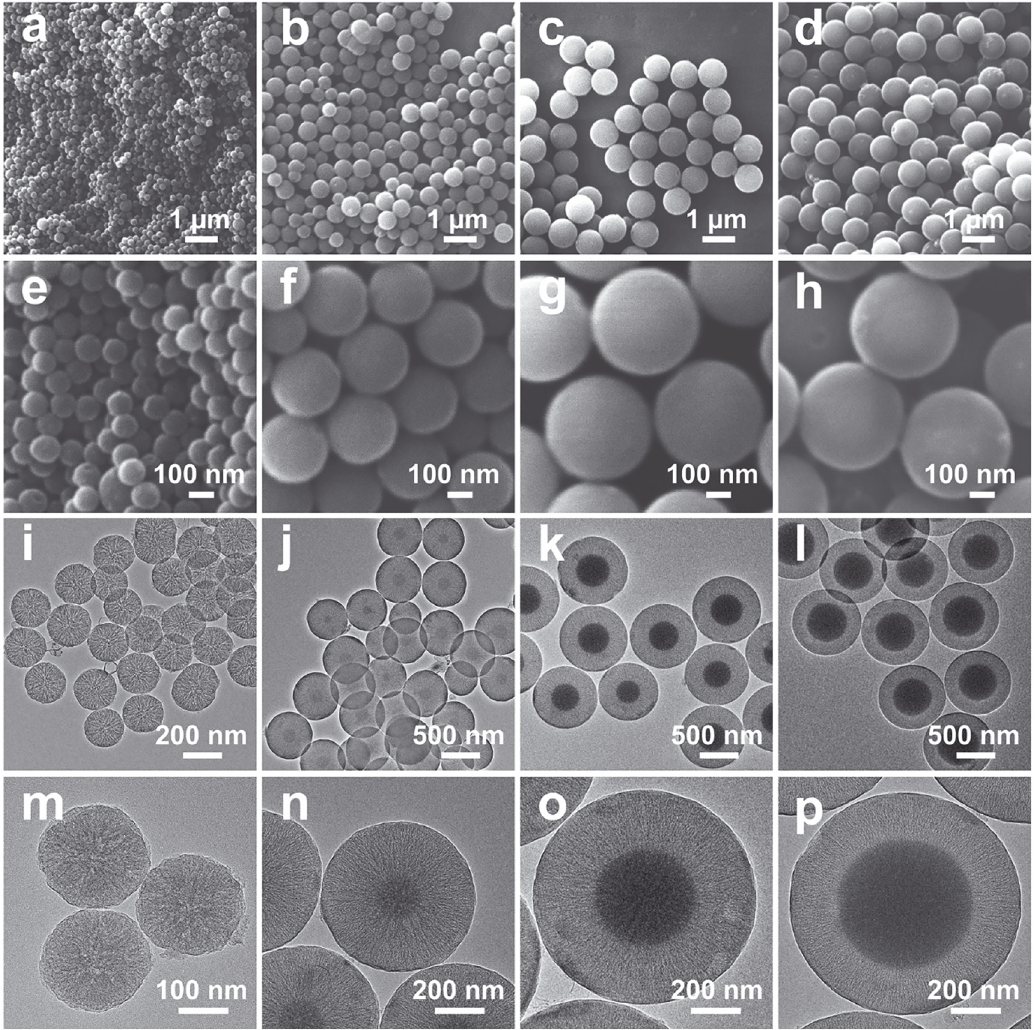
Figure 1: SEM images (a–h) and TEM images (i–p) of MCS-1 (a, e, i, m), MCS-2 (b, f, j, n), MCS-3 (c, g, k, o), and MCS-4 (d, h, l,